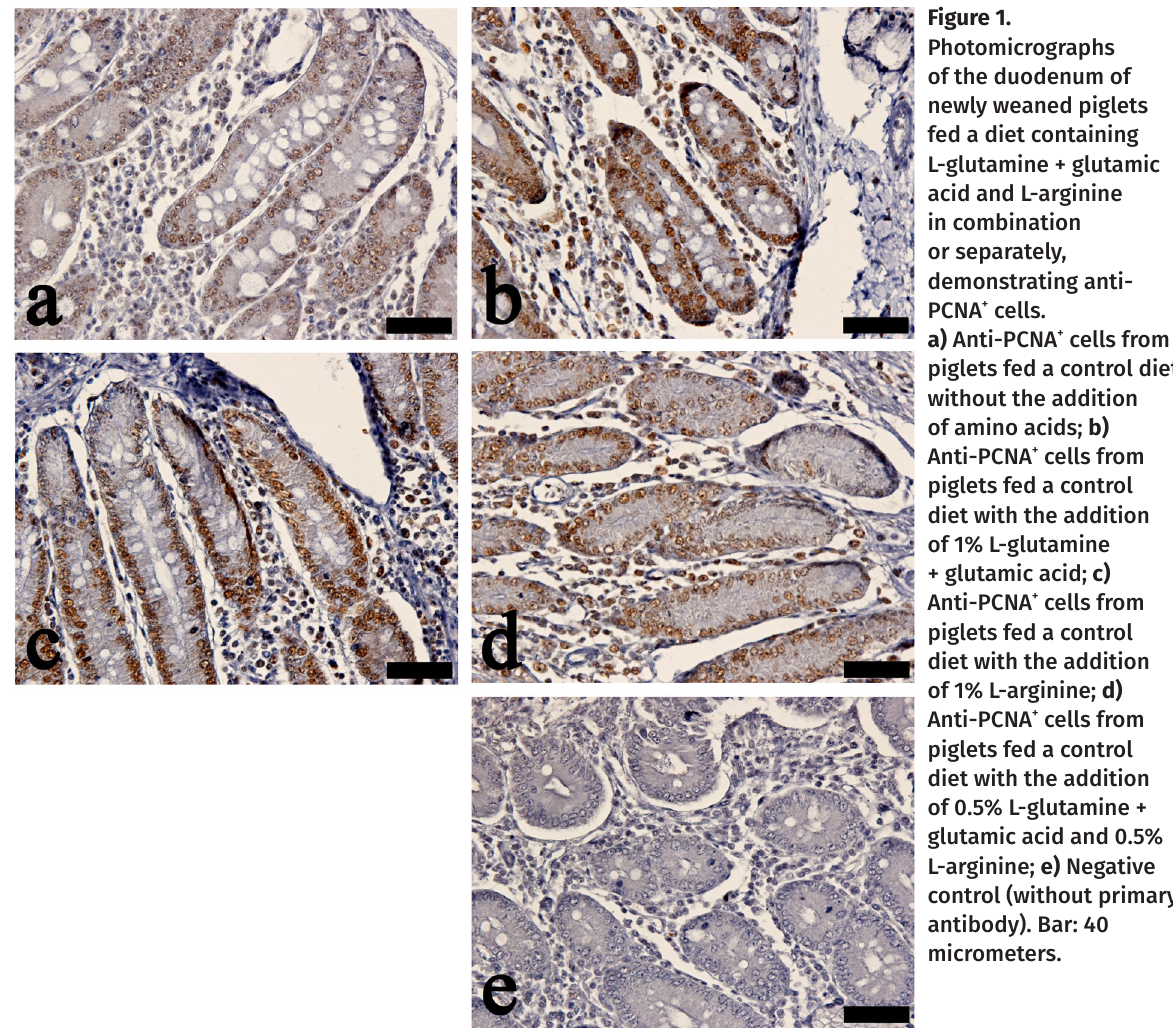
Figure 1. Photomicrographs of the duodenum of newly weaned